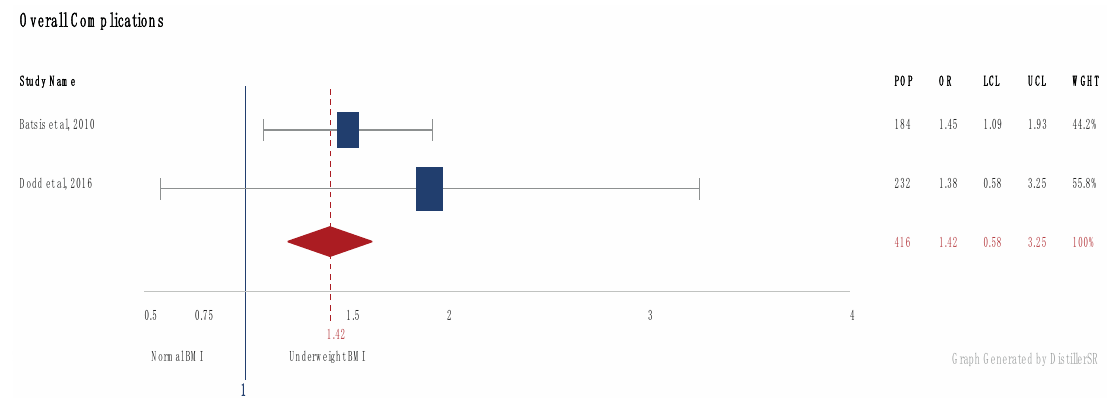
Figure 3. Forrest plot of overall complications in patients < 18.5 BMI). (Number of patients (POP), Odds Ratio (OR), Upper (UCL) and Lower (LCL) Confidence interval and Weight (WGHT). Square reflects the number of patients and the diamond represents the total effect.